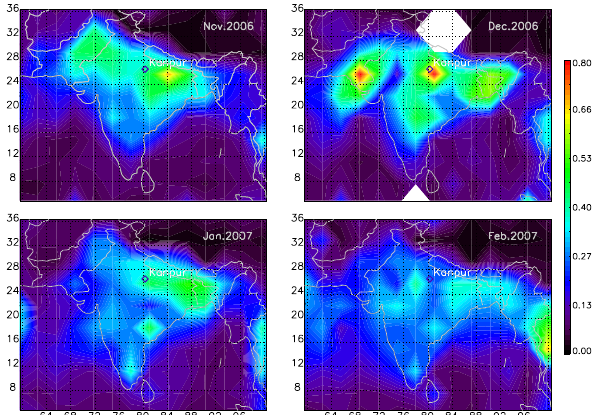
Fig. 11. Column AOD at 532nm over Eastern IGP retrieved by CALIPSO version 3 between November 2006 and February 2007. Night time data with extinction QC value of 0 or 1 in each of the layers in the column were